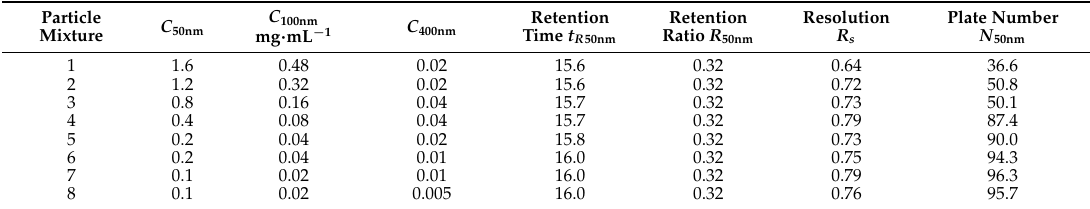
Table 4. Chromatographic parameters for the separation of mixtures of 50, 100 and 400 nm polystyrene nanoparticles with different particle